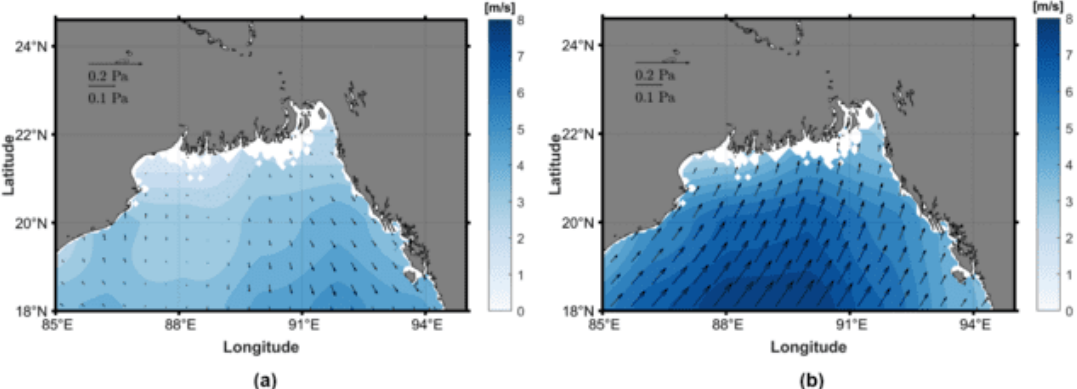
Fig. 2: The wind velocity (color in m/s) and wind stress (arrow in Pascals (Pa)) in (a) February and (b) August 2021, derived from NCEP/NCAR